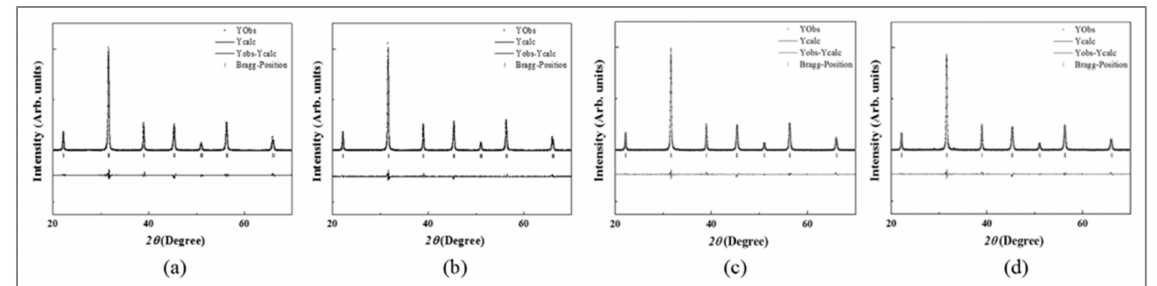
Figure 5. Rietveld refinement patterns of the 0.1 wt.% Dy 2 O 3 -doped 0.98BaTiO 3 -0.02(Ba 0.5 Ca 0.5 )SiO 3 specimens sintered at 1320 ◦ C for 1 h with various types of binders: ( a ) binder A, ( b ) binder B, ( c ) binder C, and ( d ) binder